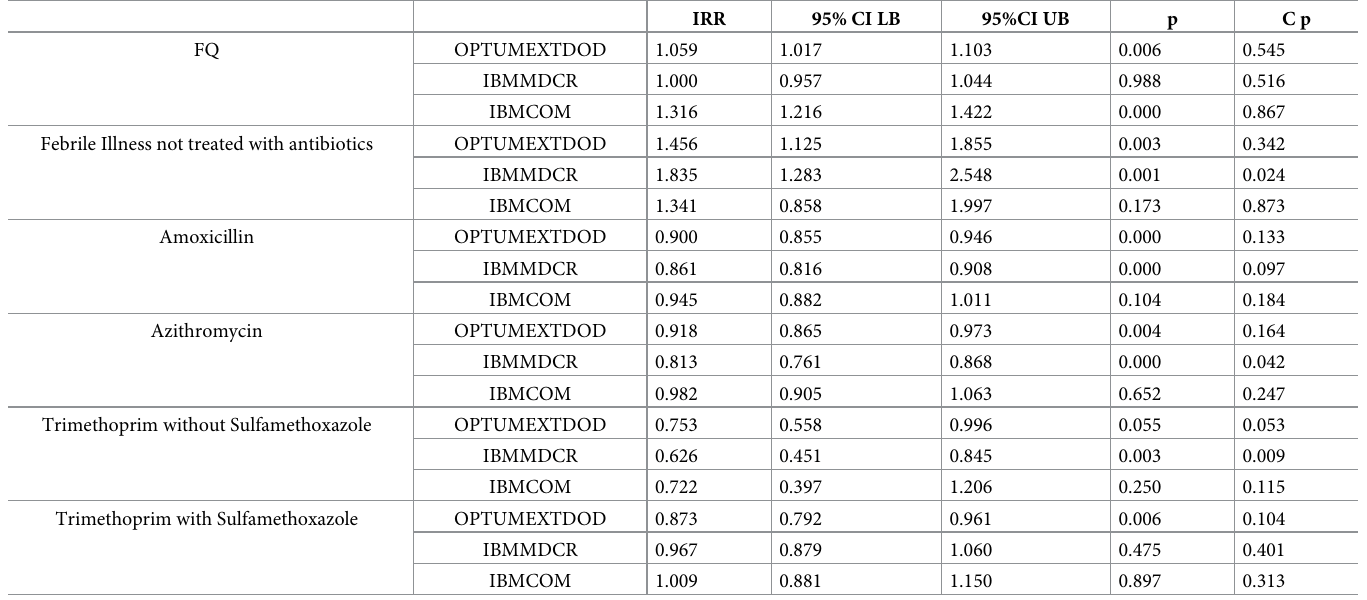
Table 4. IRR for the sensitivity analyses for which risk period was defined as exposure with 60 days with 95% confidence intervals and calibrated p values for AAD and following each exposure as indicated, for each of the databases, adjusted for age and